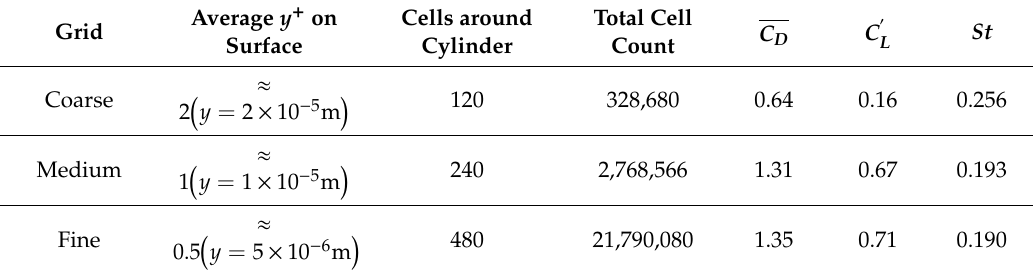
Table 3. Mesh statistics and force coe ffi cients of the grid independence